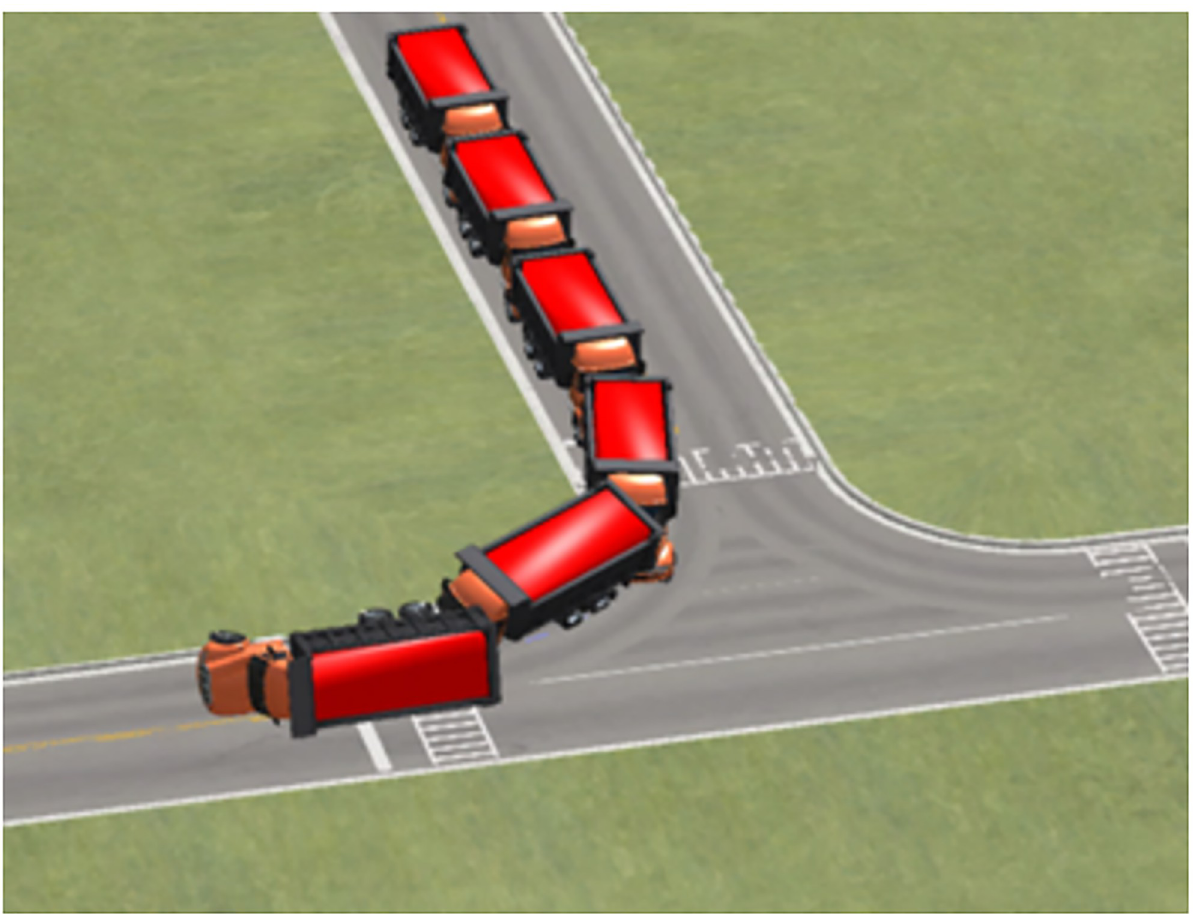
Fig 6. Vehicle rollover dynamic